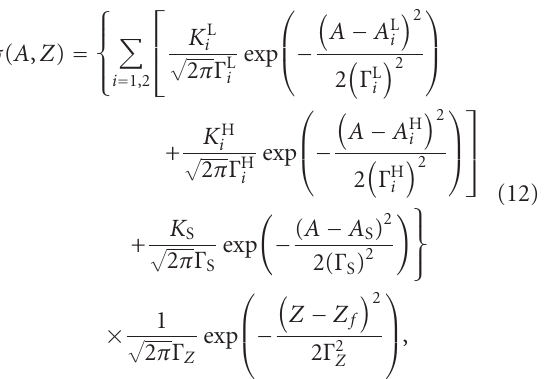
the contributions of each channel, σ i ( A , Z ), which are usually written in the